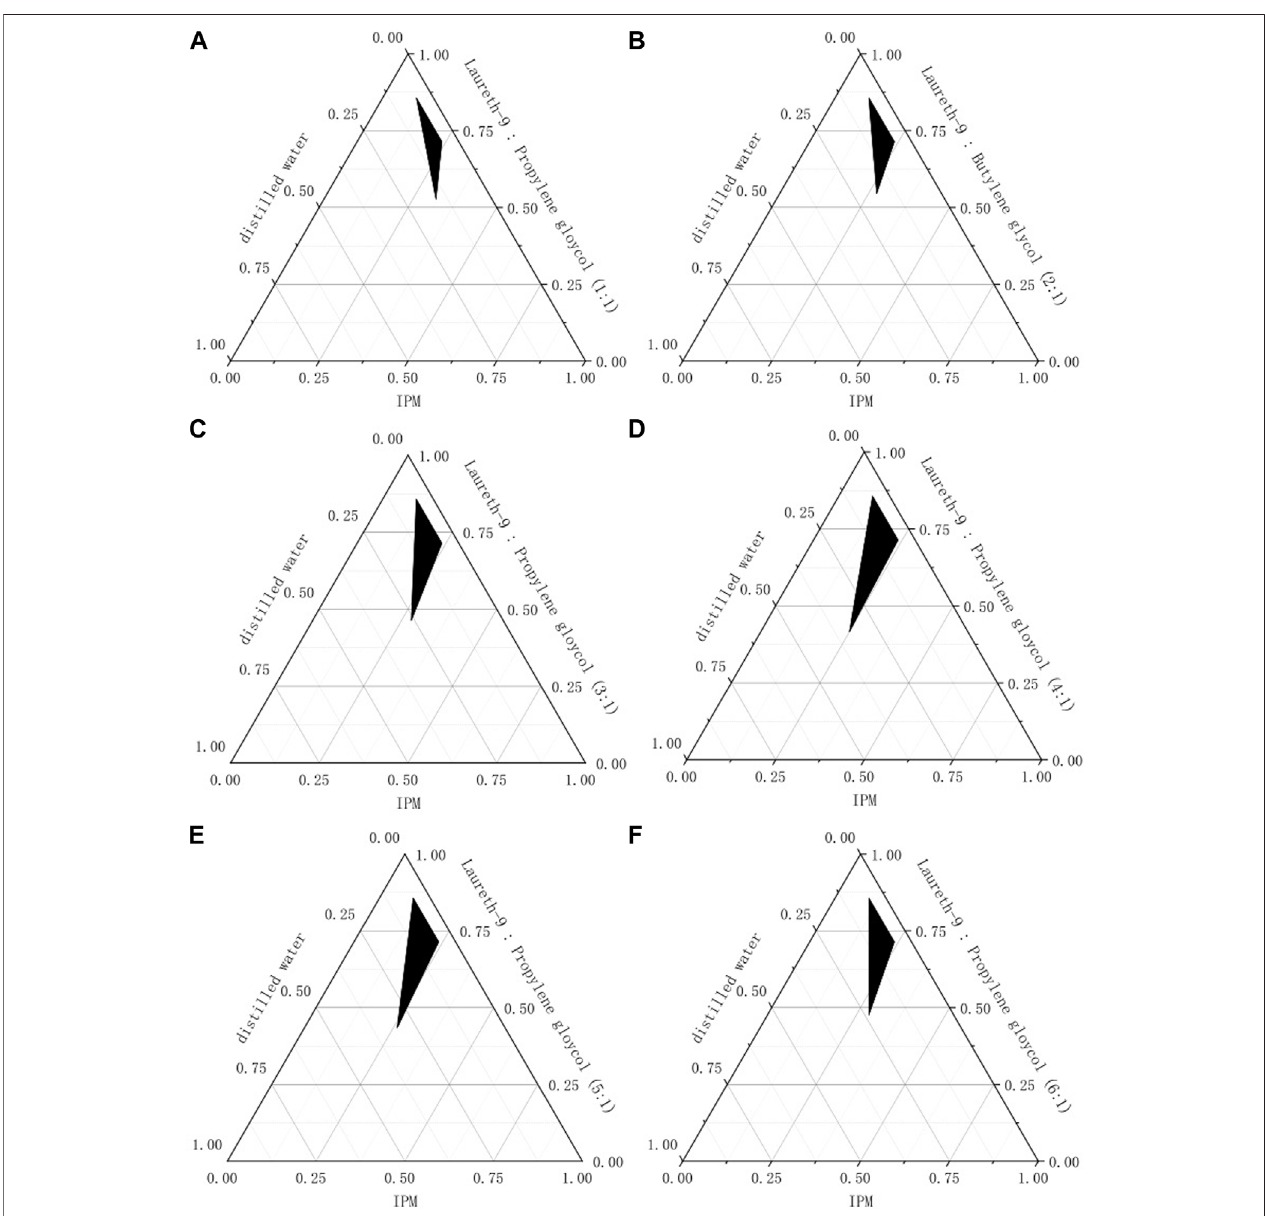
FIGURE 2 | The pseudo-ternary phase diagrams for Km (A) : Km (cid:2) 1 (B) : Km (cid:2) 2 (C) : Km (cid:2) 3 (D) : Km (cid:2) 4 (E) : Km (cid:2) 5 (E) : Km (cid:2) 6.